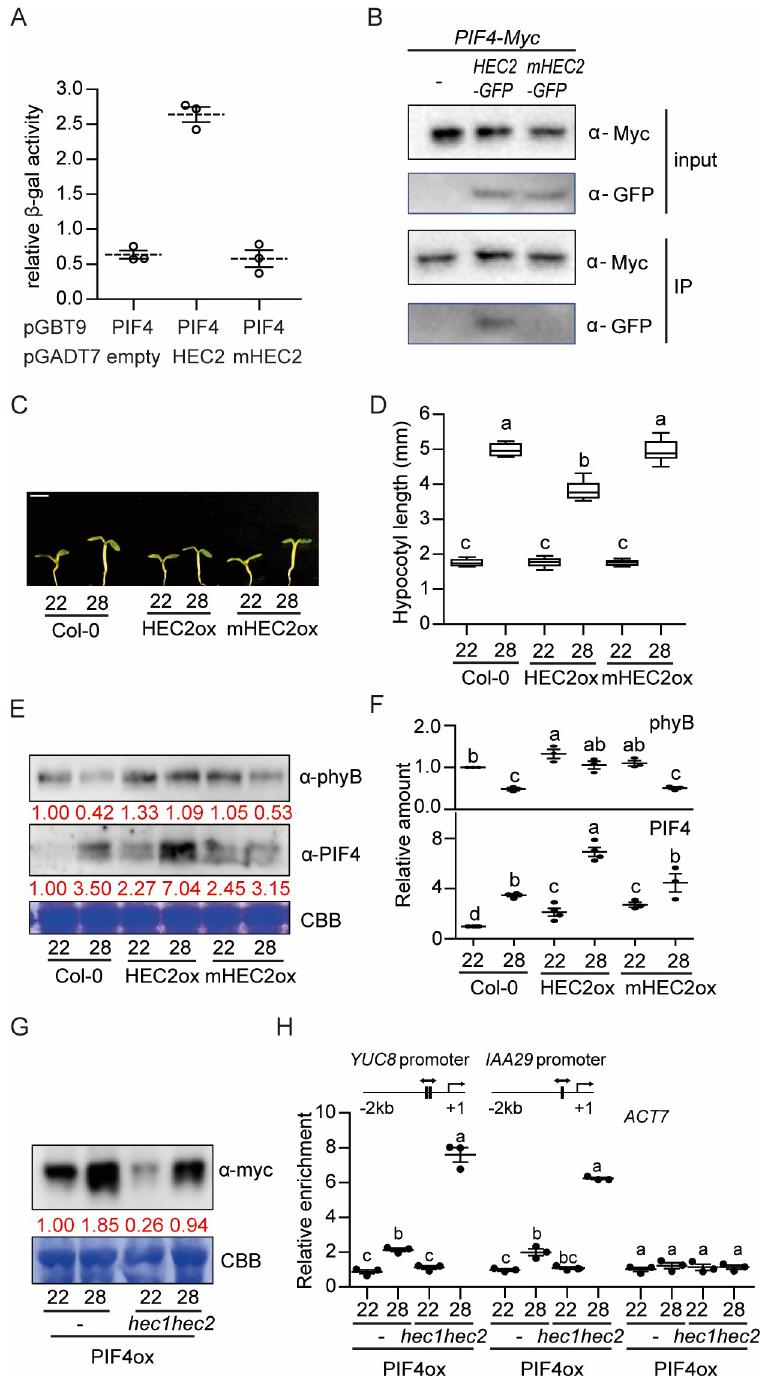
Fig 5. PIF4-HEC2 heterodimerization is crucial for HEC2 function in thermomorphogenesis. (A) HEC2 interacts with PIF4. Yeast two hybrid assay using PIF4 a bait and HEC2 or mHEC2 as preys. The error bars represent standard deviation. Three biological replicates were used in this study. (B) HEC2 interacts with PIF4 in vivo . In vivo coimmunoprecipitation assay was performed using 35S : PIF4-myc with 35S : HEC2-GFP or mHEC2-GFP crossed line. 35S:PIF4-myc was used as a control. (C) Photograph showing seedling phenotypes of WT, 35S : HEC2-GFP and 35S : mHEC2-GFP grown at normal and high ambient temperature conditions. Seedlings were grown for two days under continuous white light at 22˚C and then either kept at 22˚C or transferred to 28˚C for additional four days before being photographed. The scale bar represents 5 mm. (D) Box plot shows the hypocotyl length grown under